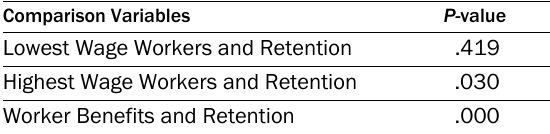
Table 6. Comparison Variables and P-values for ANOVA